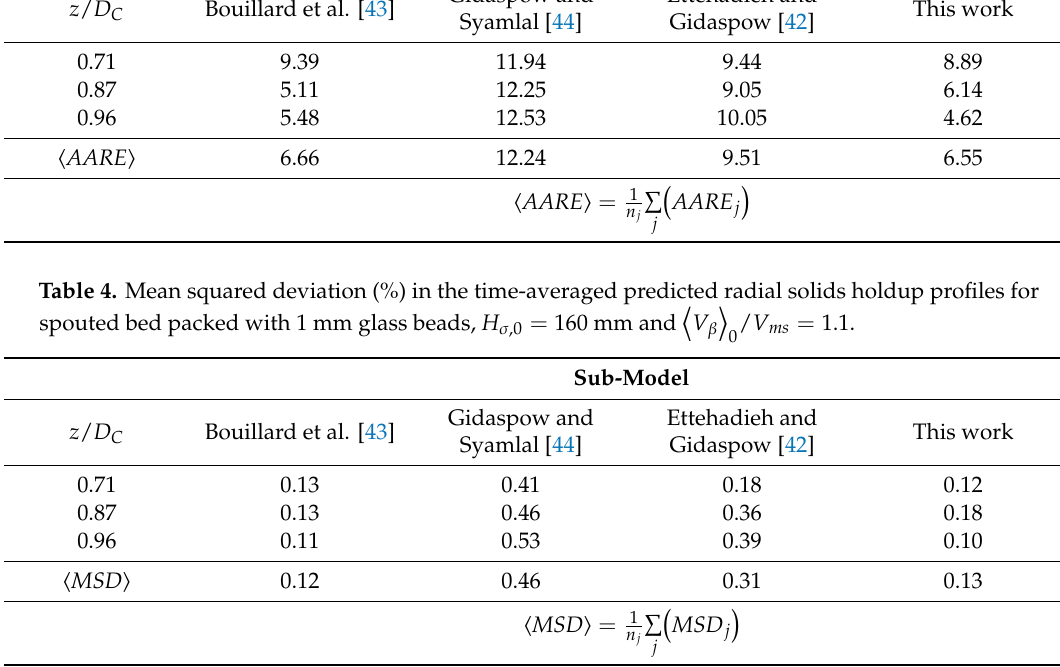
Table 3. Average absolute relative error (%) in the time-averaged predicted radial solids holdup profiles for spouted bed packed with 1 mm glass beads, H σ ,0 = 160 mm and